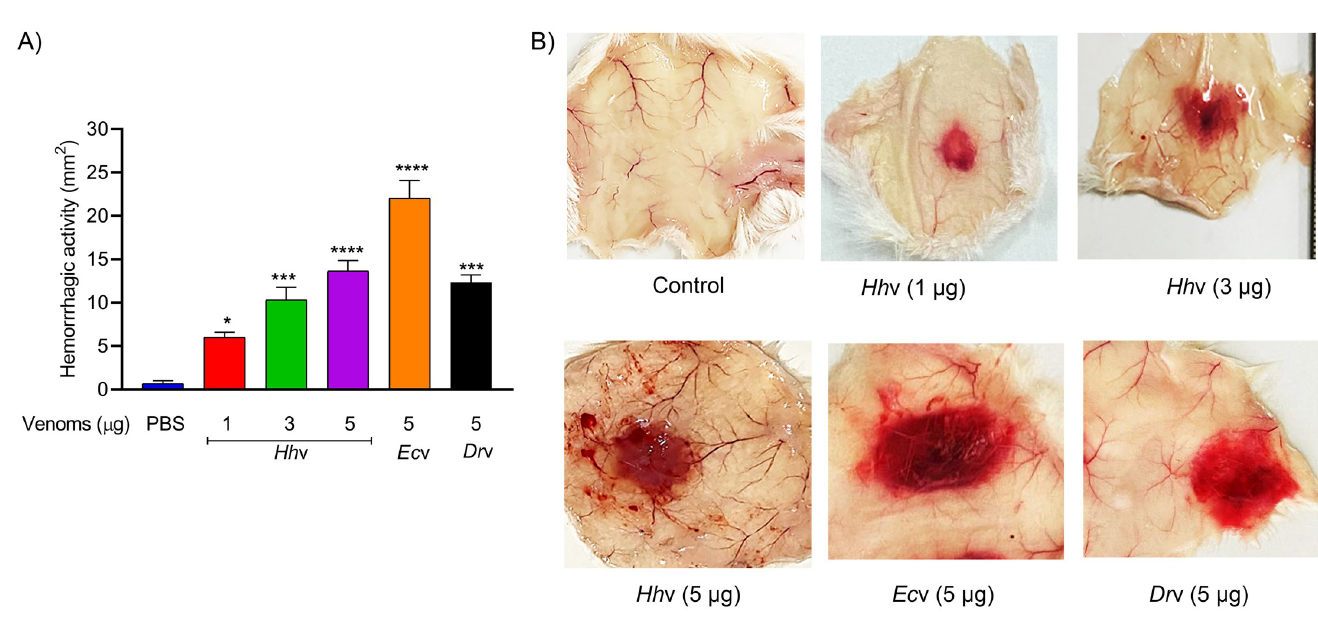
Fig 3. Murine model of hemorrhagic activity of H . hypnale , E . carinatus , and D . russelii venoms. (A) Groups of mice were independently injected intradermally with different doses, 1–5 μ g of Hh v, and 5 μ g each of Ec v and Dr v in 30 μ l PBS respectively. The group of mice were injected with PBS served as a negative control. After 3 h of injection, mice were euthanized using xylazine and removed skin at the venom injected spot, the area of hemorrhagic spots that appeared on the inner surface of the skin was measured in mm 2 . (B) The inner surface of the skin tissues shows hemorrhagic spots. The data is presented as Mean ± SEM (n = 3) and analyzed using one-way/ two-way ANOVA followed by Bonferroni post-tests, ‘ ���� p < 0.0001, ��� p < 0.001, �� p < 0.01, � p < 0.05, and ns (not significant) > 0.05. ‘ � ’ significant compared to the control group